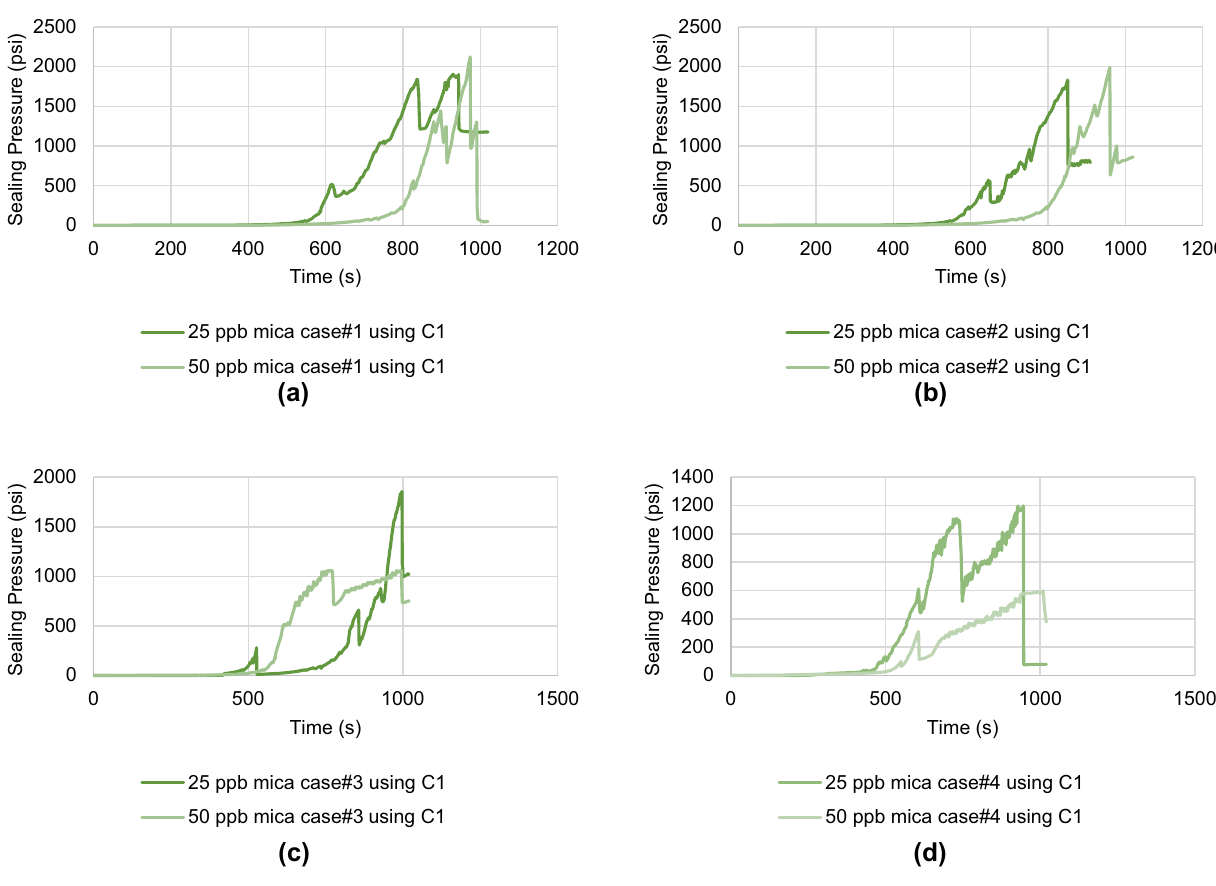
Fig. 12 HPA Pressure versus Time plot for Mica showing maximum sealing pressure at different concentration, a case#1, b case#2, c case#3, d